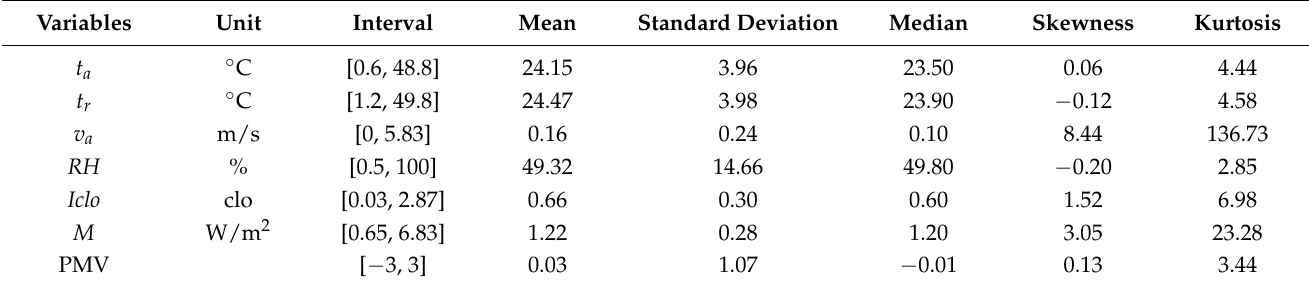
Table 1. Variable description in ASHRAE_db II